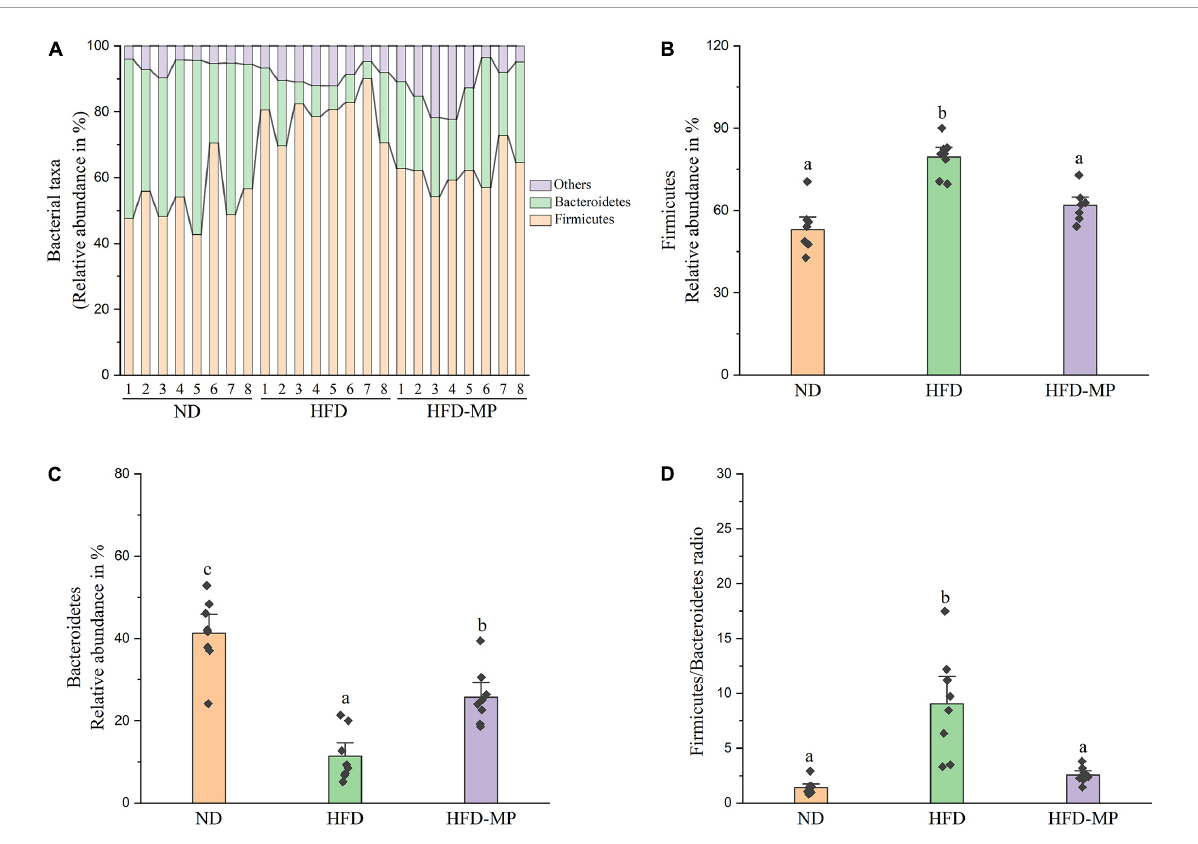
FIGURE5 MPs modulate the HFD-disrupted gut microbiota composition at the phylum level. (A) Bacterial taxonomic profiling and relative abundances of (B) Firmicutes, (C) Bacteroidetes, and (D) the ratio of Firmicutes to Bacteroidetes. The data are represented as the mean ± SEM.